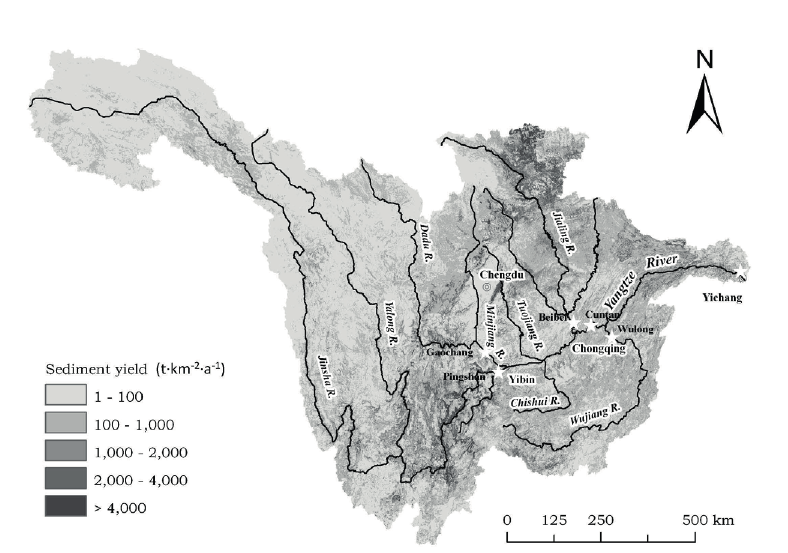
Fig. 1 A sketch map of the Upper Yangtze River Basin with specific sediment yields and the locations of key hydrometric stations. Table 1 Decadal changes of mean annual runoff discharge, suspended sediment yield and silt content in the Upper Yangtze River and its four headwater tributaries. River Area (hydro-station) (×10 4 km 2